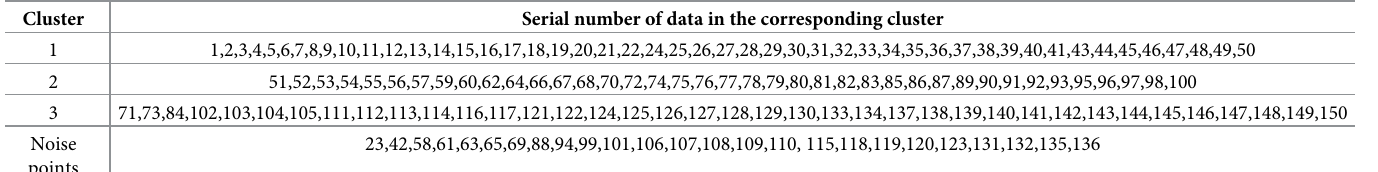
Table 3. The 3 clusters and noise points on Iris database using DBSCAN-CPPI algorith. Cluster Serial number of data in the corresponding